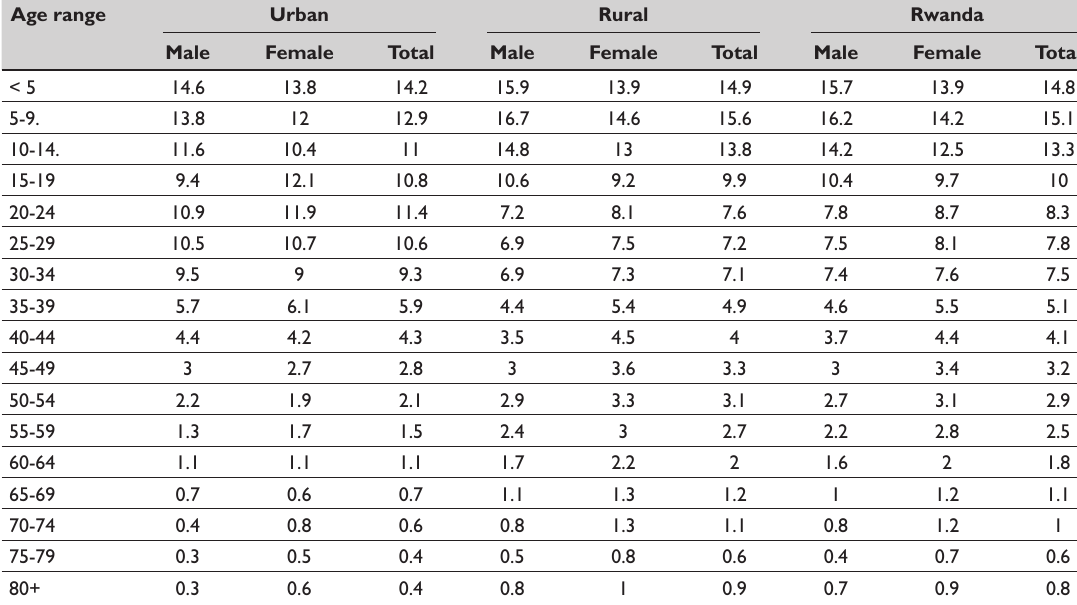
Table 2: Household population and characteristics according to age, sex, and urbanicity Age range Urban